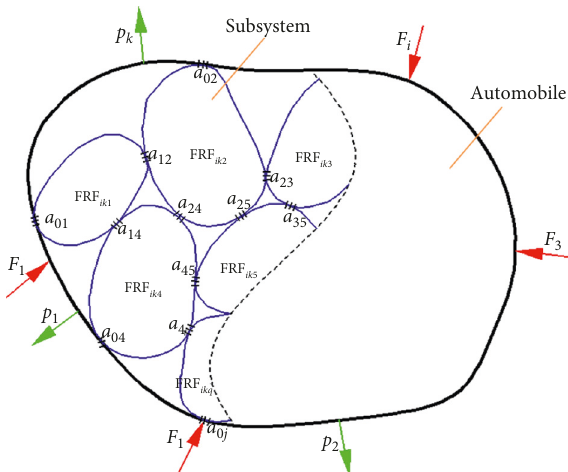
Figure 3: Sketch map of vibroacoustic energy flow in